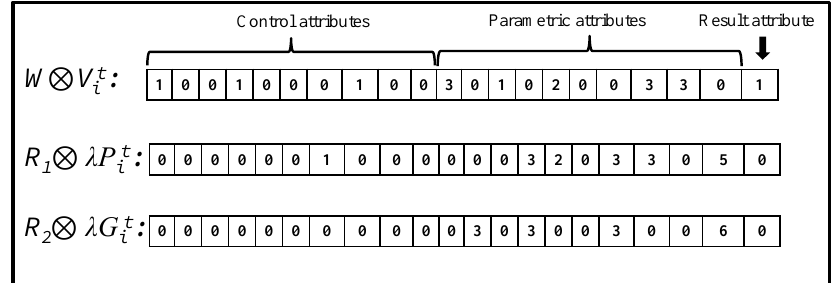
Figure 9. A sample of performing the multiply operator ( ⊗ ).